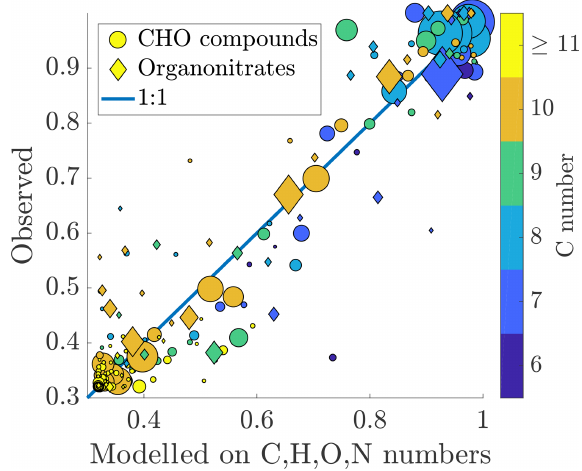
Figure 7. Measured fraction remaining vs. fraction remaining mod- elled on the chemical composition. The colouring of the circles is based on the carbon number of the compound, and the area of the circles is scaled linearly to the signal intensity, as in Figs. 5 and 6. The formula for the model is presented in Eq. (10). Number of com- pounds used for the fit: n = 232, Chi 2 statistic vs. constant model: 1 . 74 × 10 4 , p value = 0 (to machine precision). A good correspon- dence is found between the measured and fitted values, indicating that the volatility of a compound can be explained well in terms of its molecular formula. Larger deviances from the 1 : 1 line are mainly explained by carbon numbers lower than